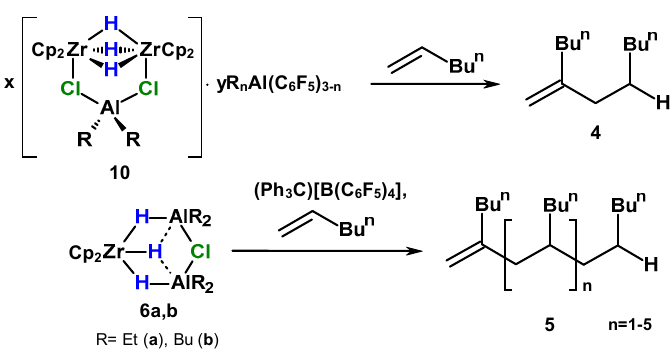
Figure 4. NMR monitoring of the reaction of complexes 7 , 9 , and 10 with 1-hexene in d 6 -benzene (intensity of upfield signals is increased): ( a ) [Cp 2 ZrH 2 ] 2 -ClAlEt 2 -(Ph 3 C)[B(PhF 5 ) 4 ] system, [Zr]:[Al]:[B] = 1:3:0.5; ( b ) [Zr]:[Al]:[B]:[1-alkene] = 1:3:0.5:3.5, 5 min; and ( c ) [Zr]:[Al]:[B]:[1-alkene] =